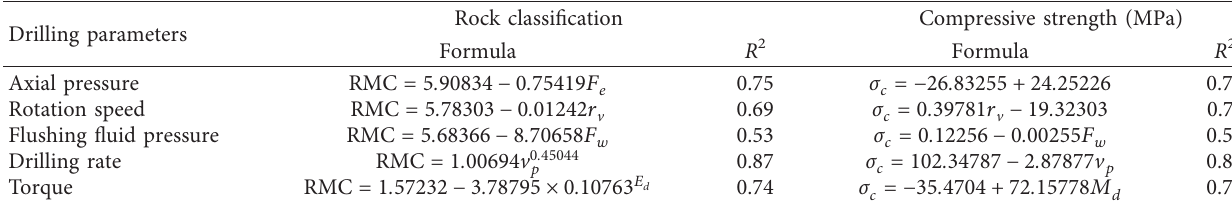
Figure 14: Relationship between rock classification, compressive strength, and torque. Table 13: Rock classification and strength prediction model based on drilling